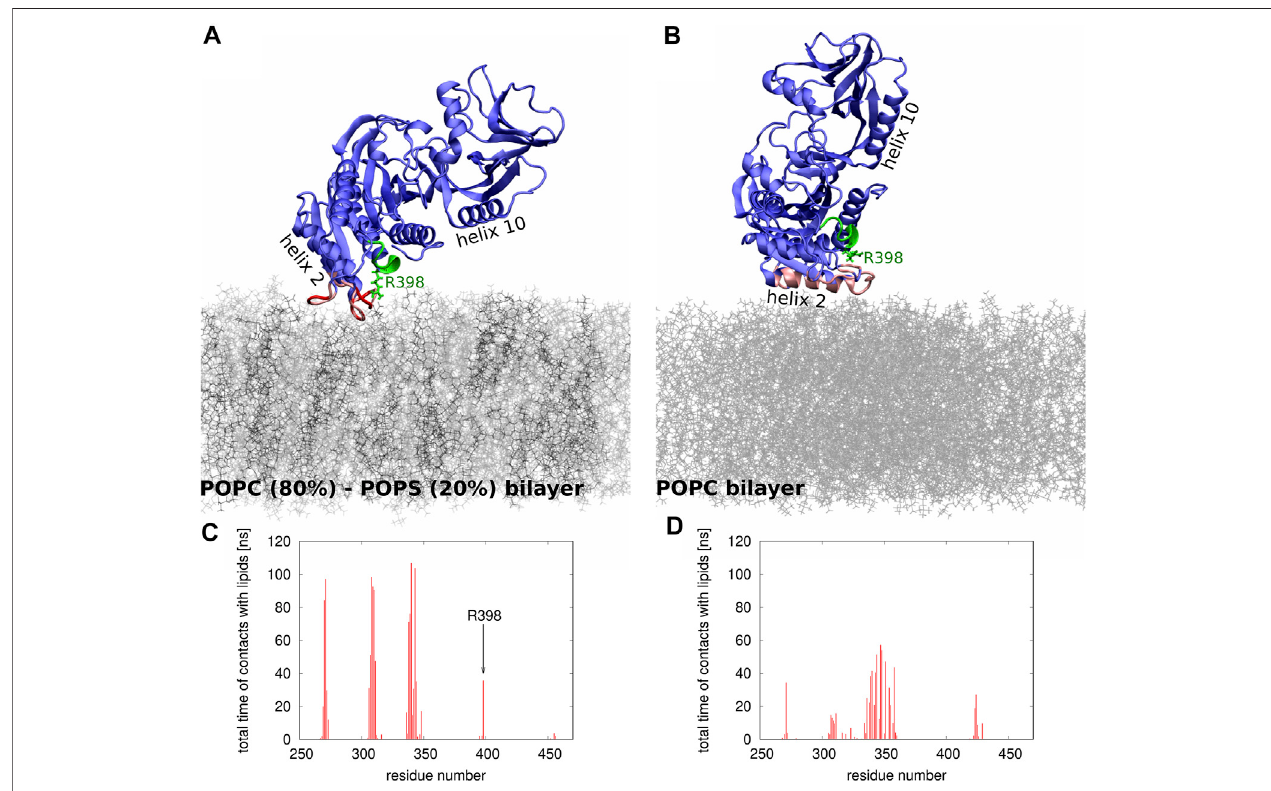
FIGURE5|(A,B) Snapshots from theMD simulations ofSac1 at(A)POPC-POPS and (B)POPC bilayer. ThePOPCand POPSmoleculesareshown asthin sticks ingrayandblack,respectively.TheSac1moleculeisshowninblueexceptfortheregionsthatmakestrong(showninred)ortransient(showninpink)contactswithlipids. ThecatalyticP-loopisshowningreen.Helices2and10areindicatedtoshowthedifferencesinhowSac1isorientedrelativeto (A) POPC-POPSand (B) POPCbilayers. Arg 398 is shown in stick representation. (C,D) Histograms showing which amino acid residues and how frequently make contacts with (C) POPC-POPC and (D) POPS bilayers.